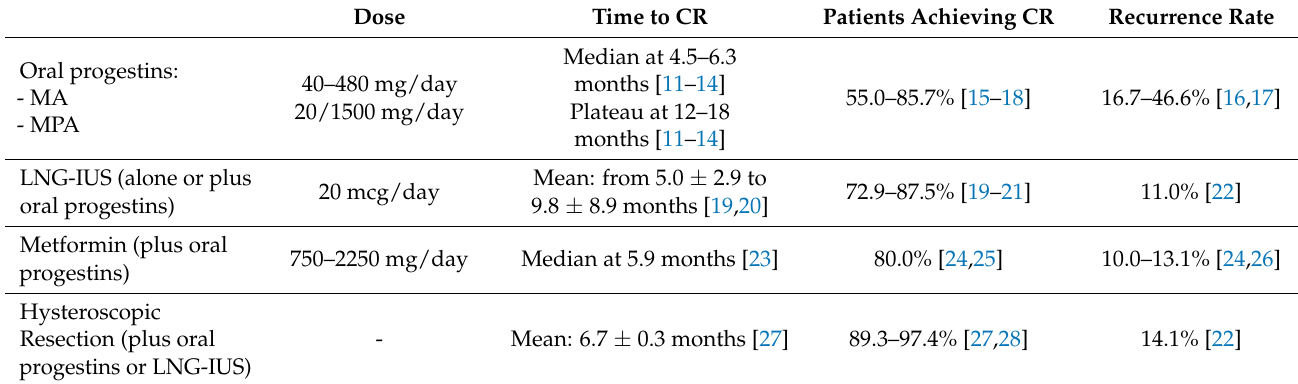
Table 1. Efficacy outcomes of fertility-sparing